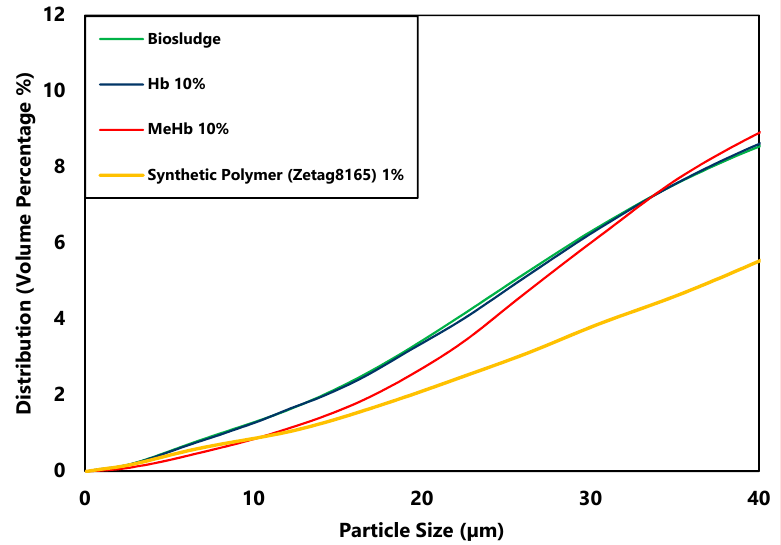
Figure 4. Particle size distribution of raw biosludge and conditioned biosludge with 10% of hemoglobin and methylated hemoglobin within the range of 0–40 µ m.